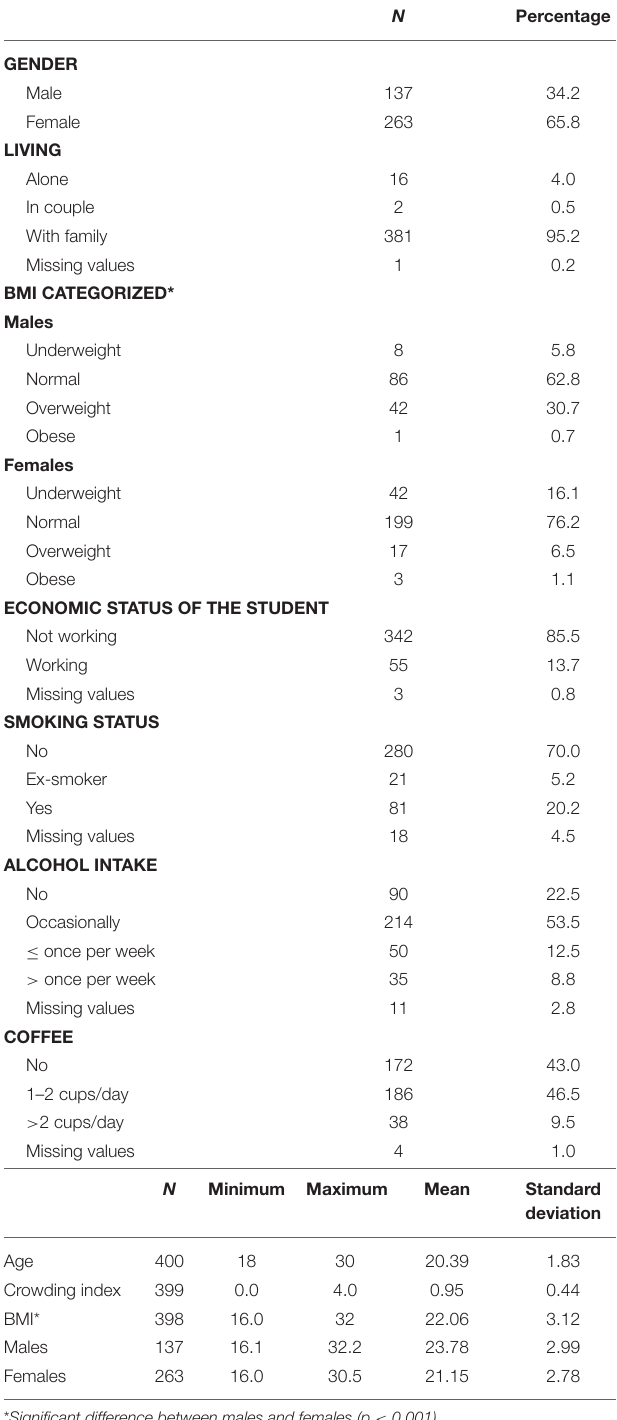
TABLE 1 | Sociodemographic characteristics of the